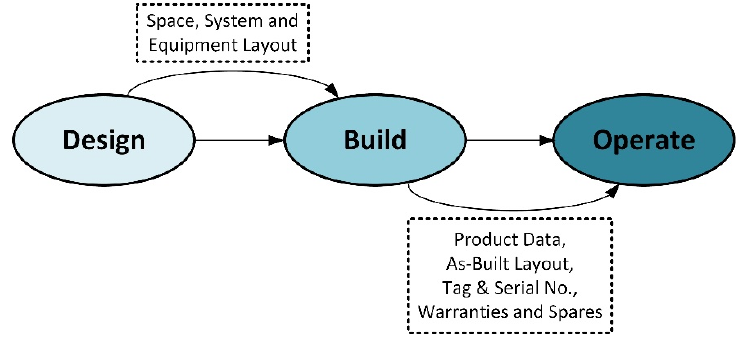
Figure 1. COBie process (Adapted from East William, 2007).